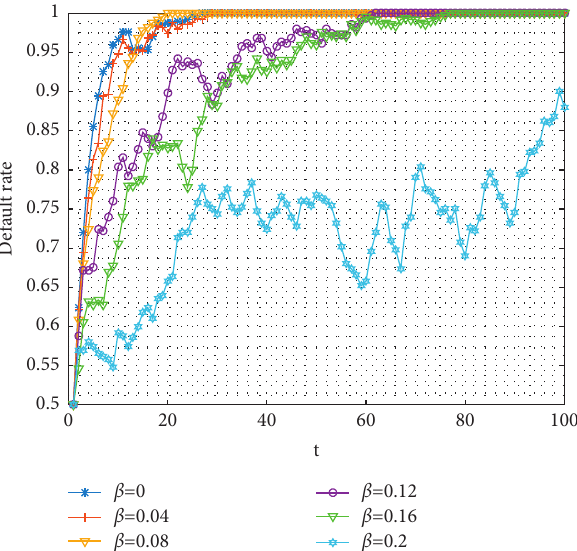
Figure 3: Diffusion of default behavior in a small-world network when β < β